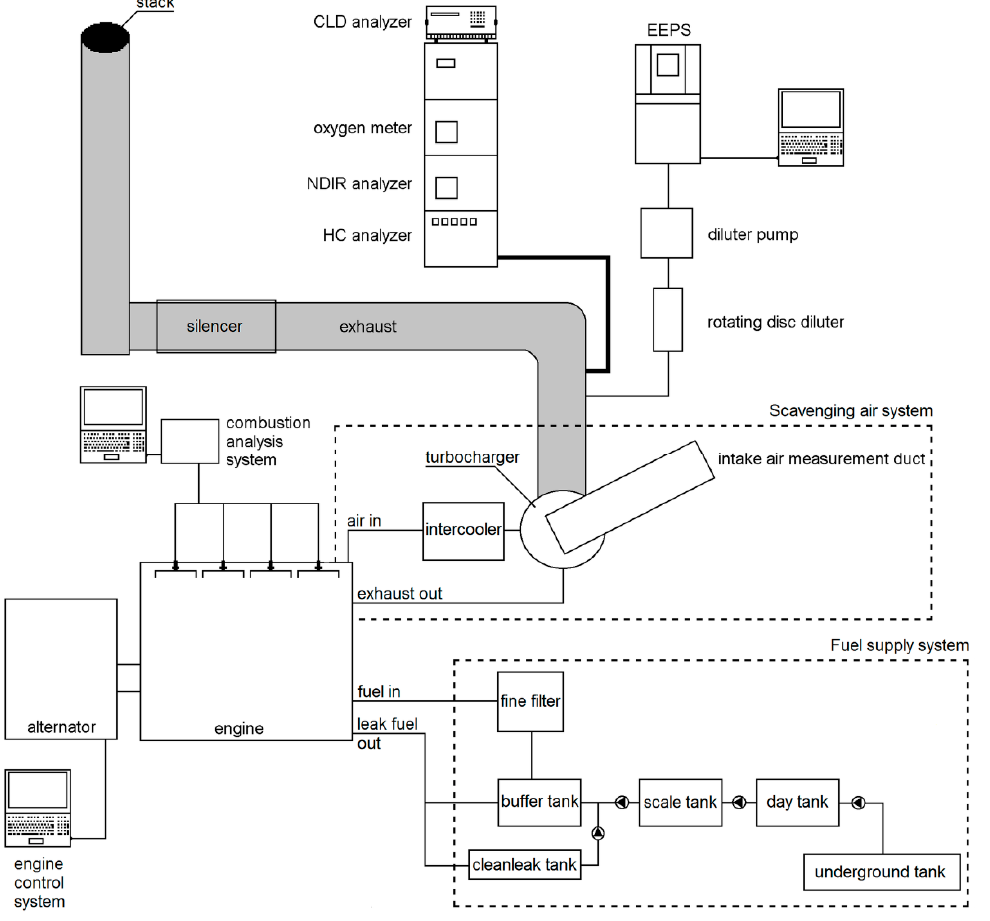
Figure 1. Experimental set-up.